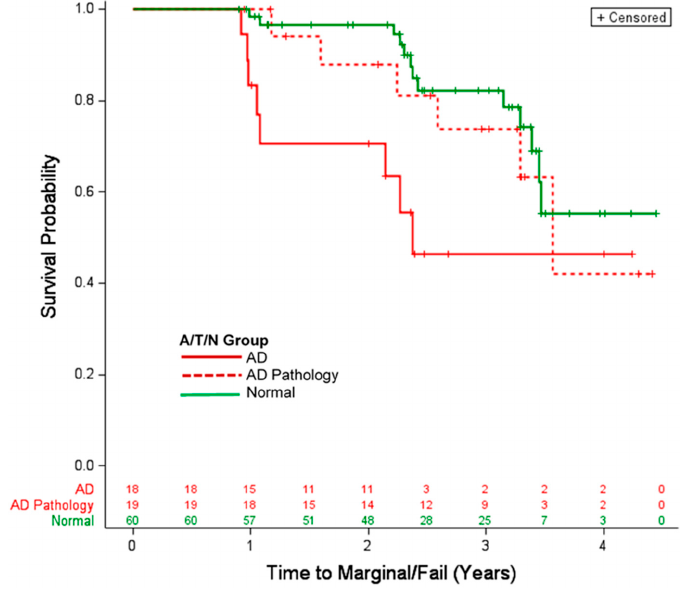
Figure 1. Time from baseline in years to receiving a Marginal or Fail rating as a function of A/T/N parent group membership. Numbers below the X-axis indicate the number of participants at risk at that time. Geriatrics 2018 , 3 , x FOR PEER REVIEW